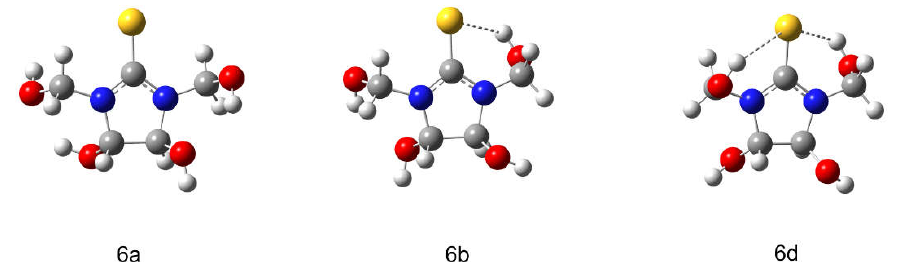
Figure 6. Formation of intramolecular hydrogen bonds in 4,5-dihydroxy-1,3-bis(hydroxymethyl) imidazolidine-2-thione 6t